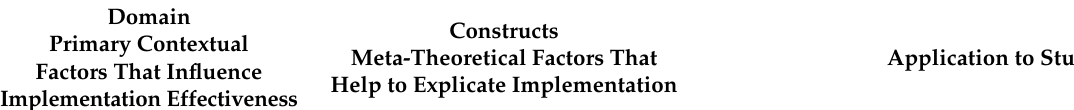
Table A1. Descriptions of Consolidated Framework for Implementation Research (CFIR) Domains and Constructs Applied to Total Worker